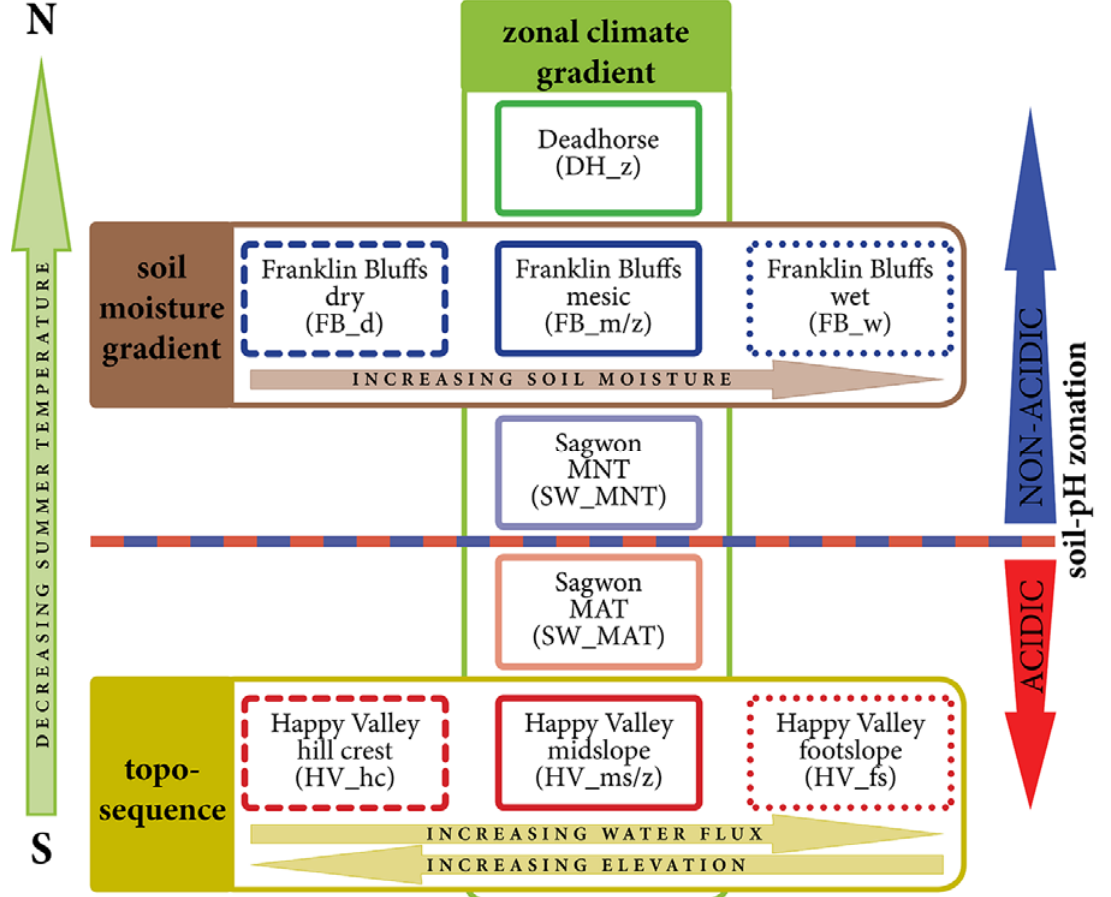
(zonal climate, soil pH, soil moisture, and toposequence/hillslope) along the Low Arctic part of the